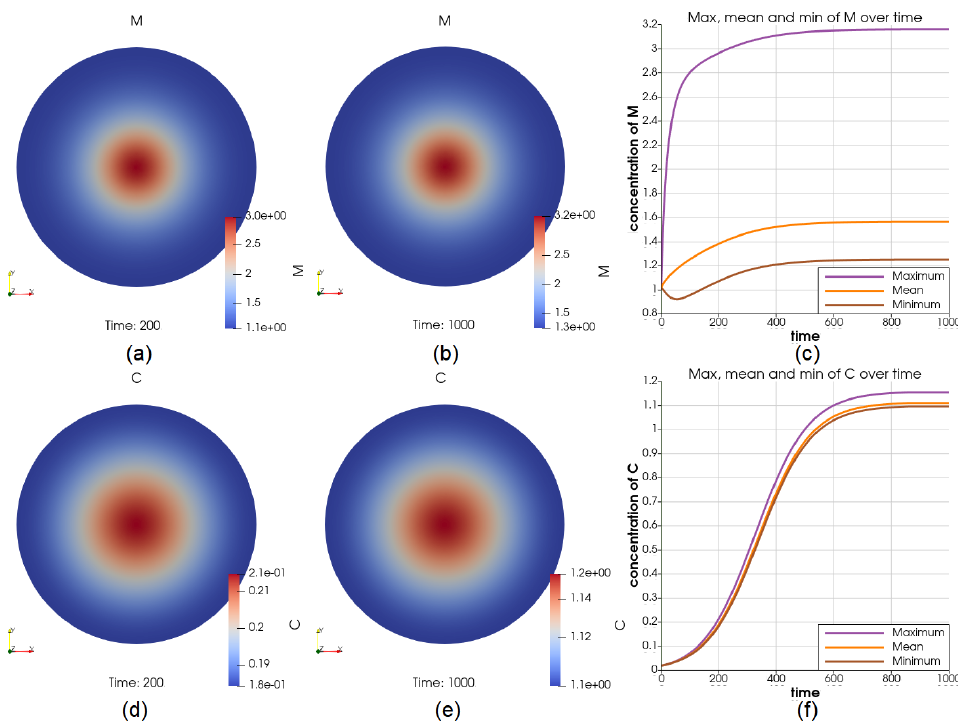
Figure 7. Illustrations for the case of a source of M in the middle. Sub-figure ( a , b ) show the value of M at t = 200 and t = 1000, respectively; ( c ) shows the dynamics of the maximum and minimum of M , from where we can see that the source has introduced a significant amount of increase in the middle; the cancer cell concentration at t = 200 and t = 1000 are shown in ( d , e ); the value of the maximum and minimum of C over the whole time interval is shown in ( f ). These figures suggest that the cancer cells will be at the place where there are more macrophages, yet the concentration still reaches a steady